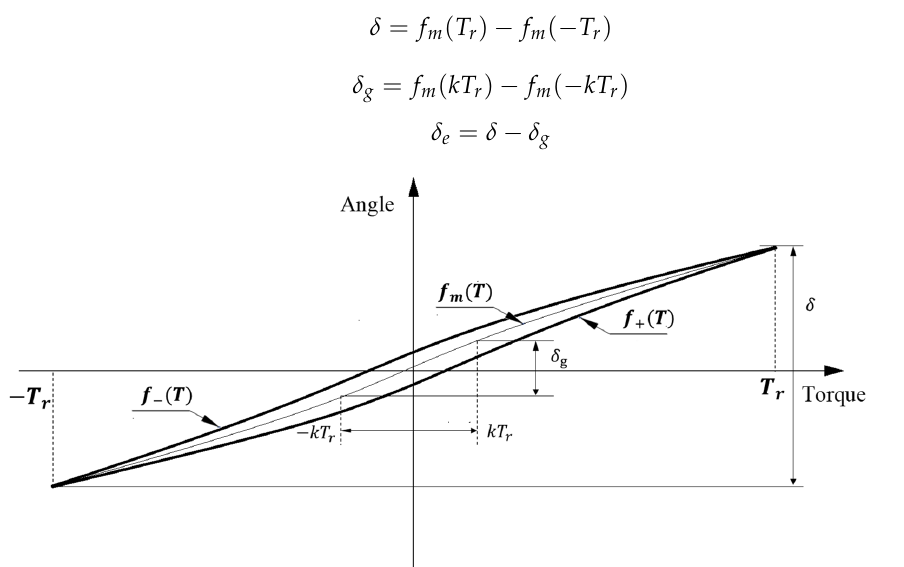
responding to the same output torque in 𝑓 (cid:2878) (cid:4666)𝑇(cid:4667) and 𝑓 (cid:2879) (cid:4666)𝑇(cid:4667) . Equations (27)–(29) show the relationship between 𝛿 , 𝛿 (cid:3034) and 𝛿 (cid:3032) in the hysteresis curve. 𝑇 (cid:3045) is the rated torque at the output end, 𝑘 represents 𝛿 (cid:3034) the selected coefficient. This is affected by factors, such as reducer processing and installation, and is usually specified according to actual needs.